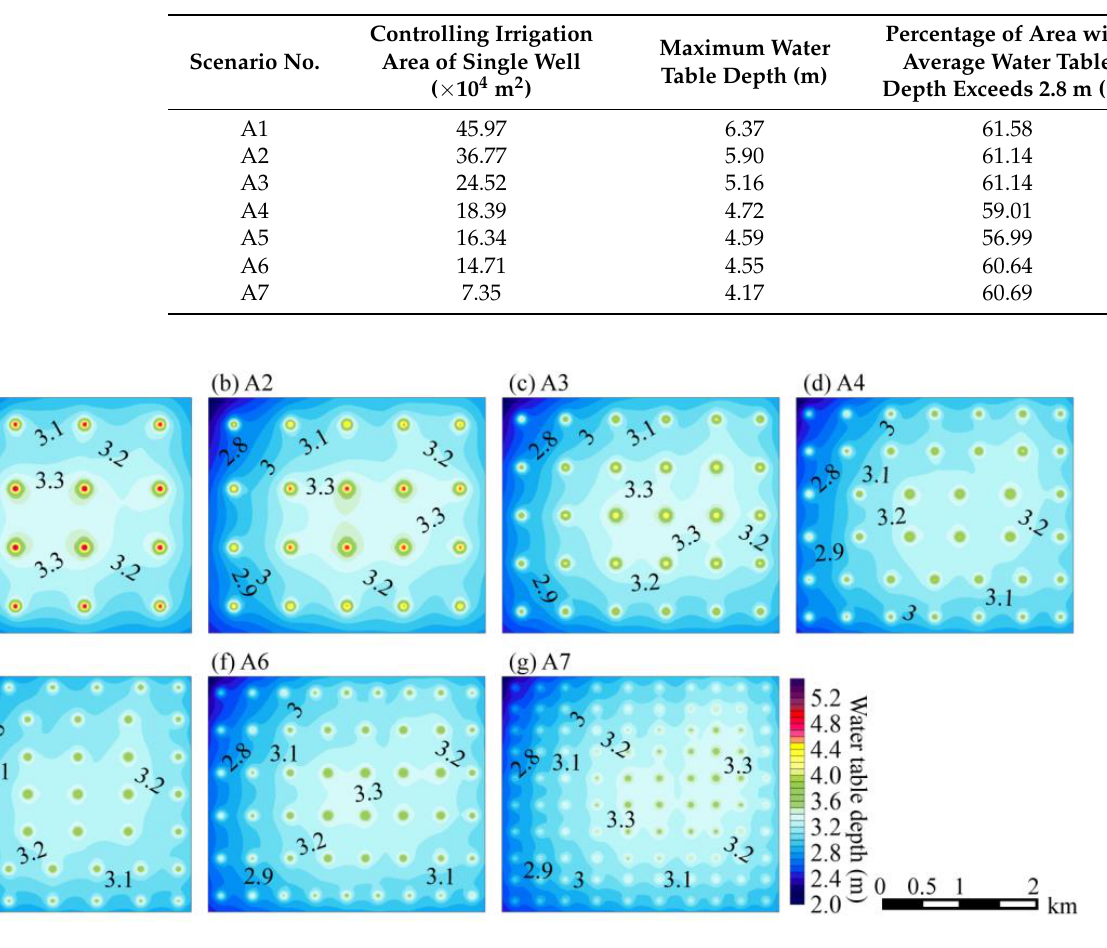
Figure 9. Spatial distribution of average water table depth during the growth period under ( a ) Scenario A1, ( b ) Scenario A2, ( c ) Scenario A3, ( d ) Scenario A4, ( e ) Scenario A5, ( f ) Scenario A6, ( g ) Scenario A7 with different controlling irrigation area of single well.